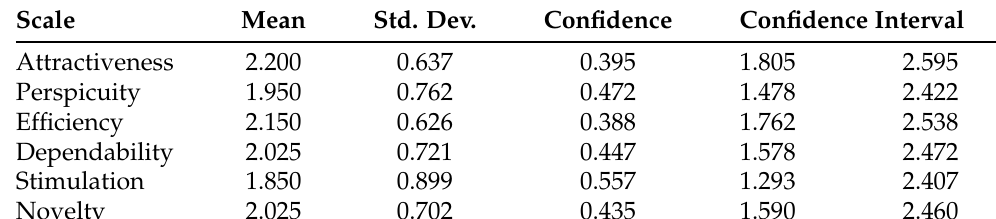
Table 2. Teachers results ( n = 10). Confidence interval ( p = 0.05) per scale.